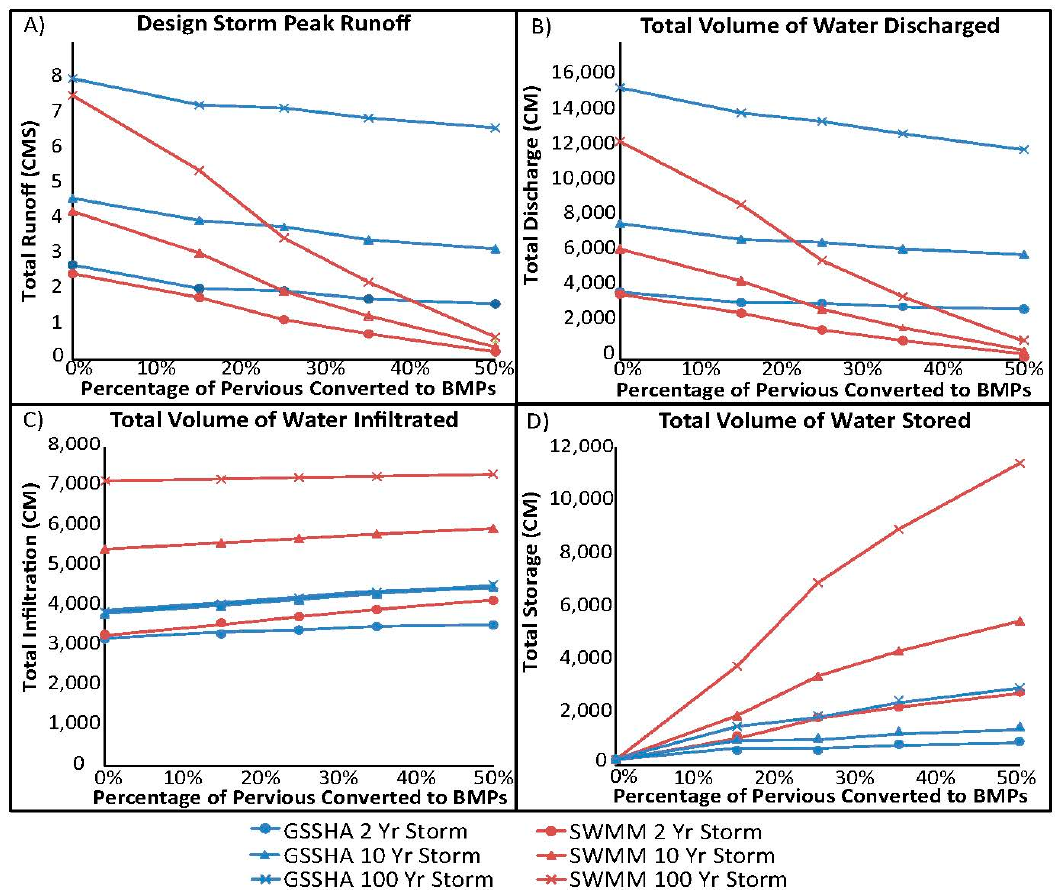
Figure 4. Green Infrastructure comparison results. Gridded Surface Subsurface Hydrologic Analysis (GSSHA) results are presented in blue, and Storm Water Management Model (SWMM) results are presented in red for each simulation and storm event. The results are presented for: Peak Runoff ( A ); Runoff Volume ( B ); Total Infiltration Volume ( C ); and Total Storage ( D ).